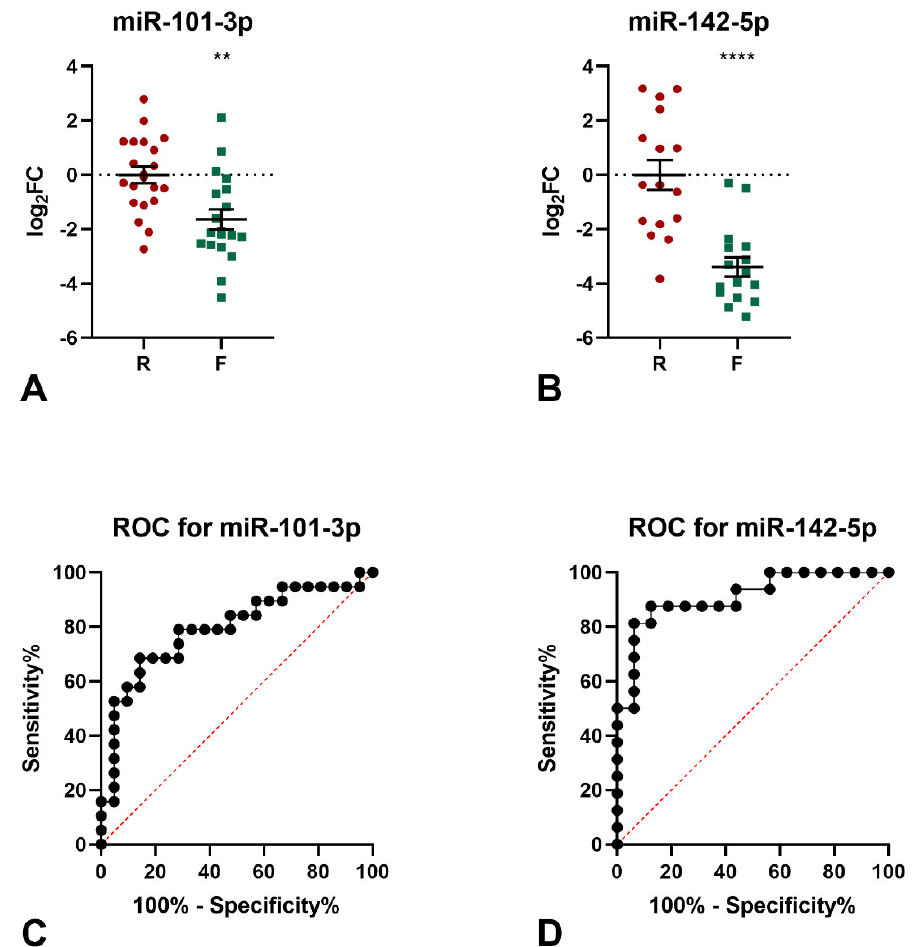
Figure 1. Results of qPCR analyses of miR-101-3p and mir-142-5p. ( A ) qPCR analysis of miR-101- 3p expression. Two-tailed t -test: ** p < 0.01 F vs. R. ( B ) qPCR analysis of miR-142-5p expression. Two-tailed t -test: **** p < 0.0001 F vs. R. ROC analysis for the ability of miR-101-3p levels ( C ) and miR-142-5p levels ( D ) to discriminate between frail and robust subjects.